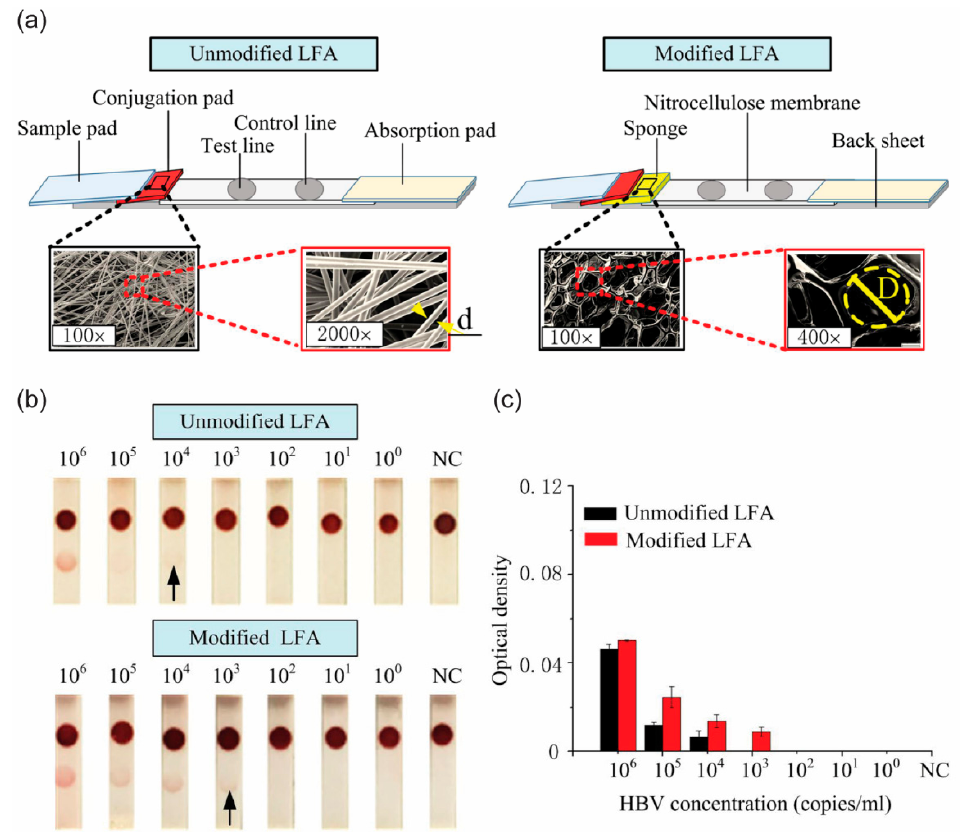
Figure 17. Increasing the detection sensitivity by regulating the flow of the fluid sample in a p-CMF device. ( a ) For lateral flow assay, a sponge was incorporated into a p-CMF device to decrease the flow rate of the fluid sample. ( b , c ) Comparison of the colorimetric detection signals of hepatitis B virus (HBV) for the unmodified and the modified p-CMF devices. Adapted with permission from the authors of [89]. Copyright 2017 under a Creative Commons Attribution.